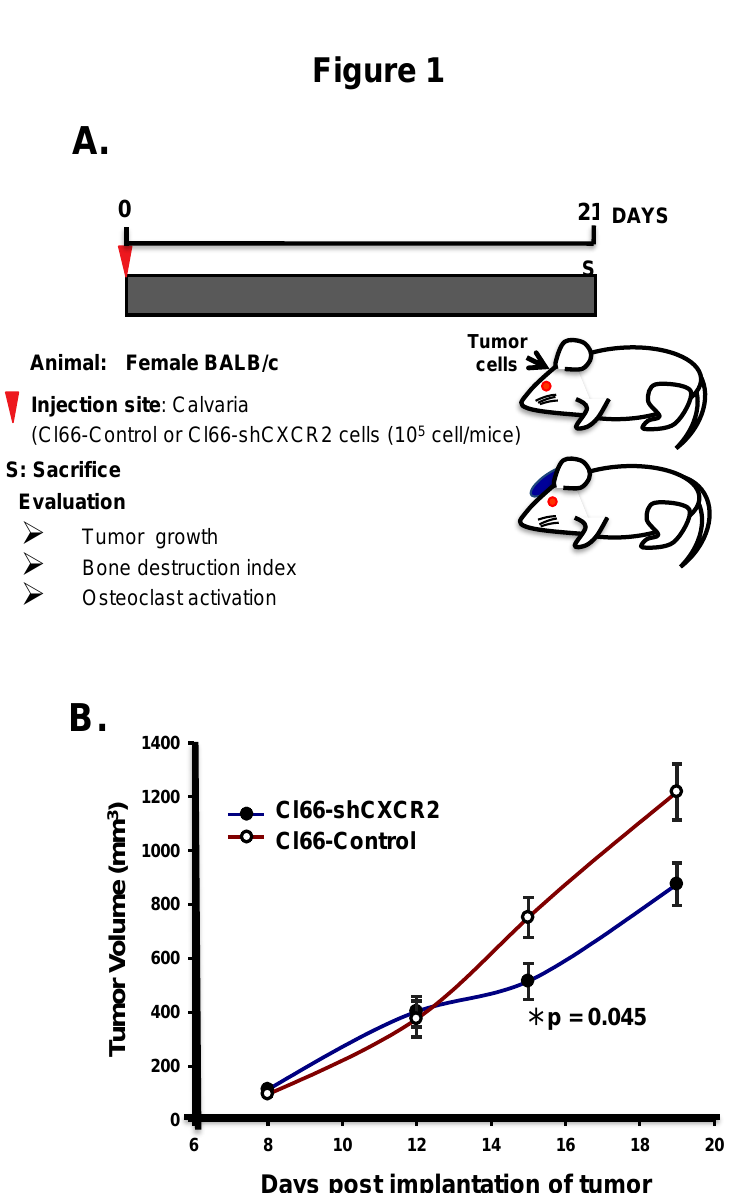
Figure 1. Downregulation of CXCR2 in tumor cells reduces calvarial tumor growth. ( A ) Schematic representation of the tumor cell injections in Balb/c mice. Injection of Cl66-Control or Cl66-shCXCR2 cells mixed and suspended in 25 µ L of Hank’s Balanced Salt solution and 25 µ L of growth factor reduced matrigel on the dorsal side on calvaria of Balb/c mice using a 23 gauge needle is marked as day 1. Mice were monitored for 21 days for tumor growth and sacrificed. ( B ) The graph shows the growth kinetics of tumor formed by Cl66-Control and Cl66-shCXCR2 cells on the calvaria of Balb/c mice. Statistical analysis was performed using the Mann-Whitney Rank Sum Test with * p = 0.045 and n = 5 per